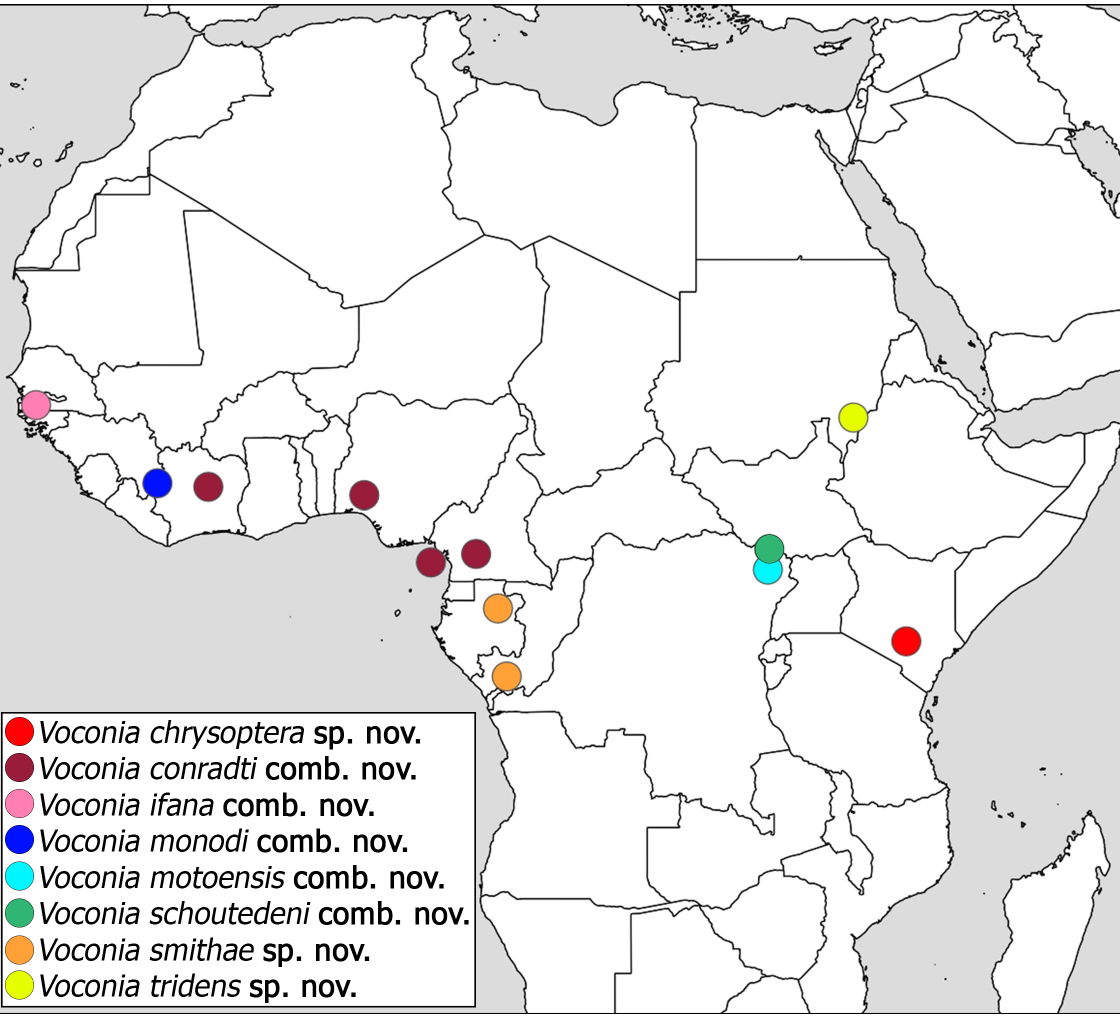
Fig. 17. The distribution of species of Voconia Stål, 1866 in